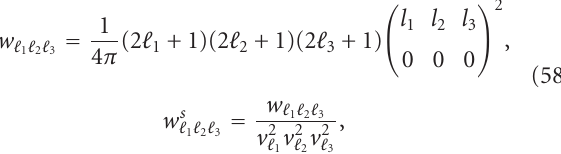
V T defined by the triangle condition for multipole